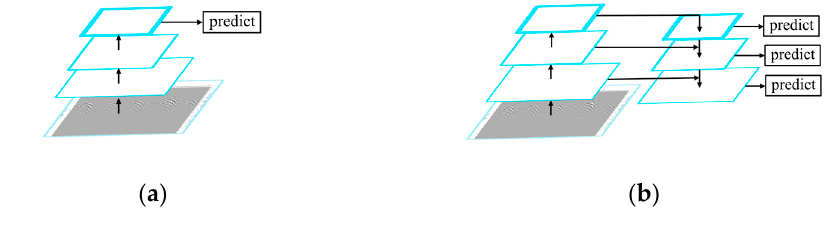
Figure 9. ( a ) Single feature layer structure; ( b ) FPN structure.